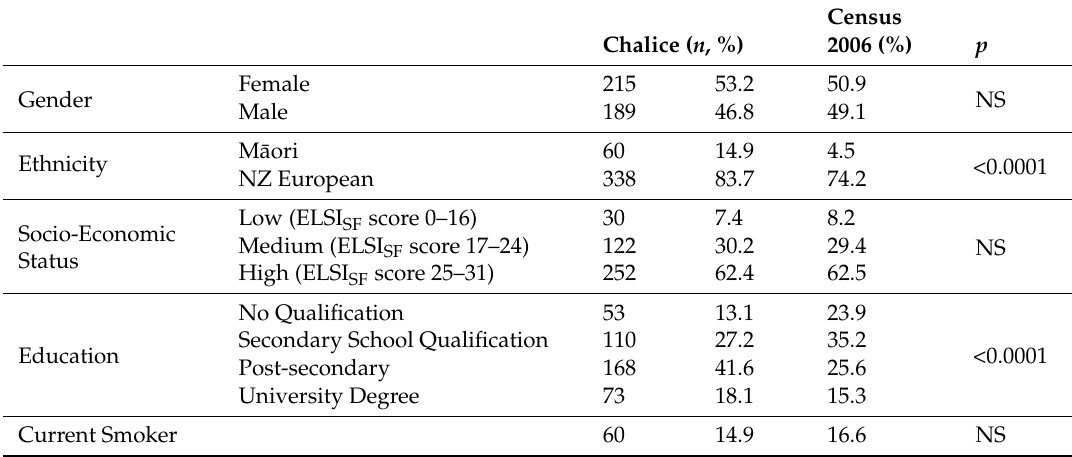
Table 1. CHALICE participants compared with Census 2006 50–54-year-olds from same region.